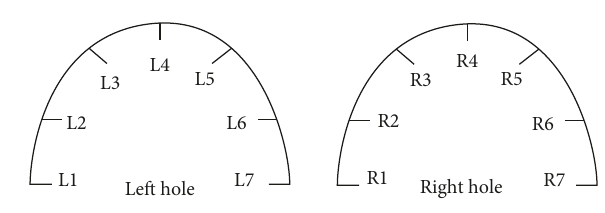
Figure 6: Numerical calculation